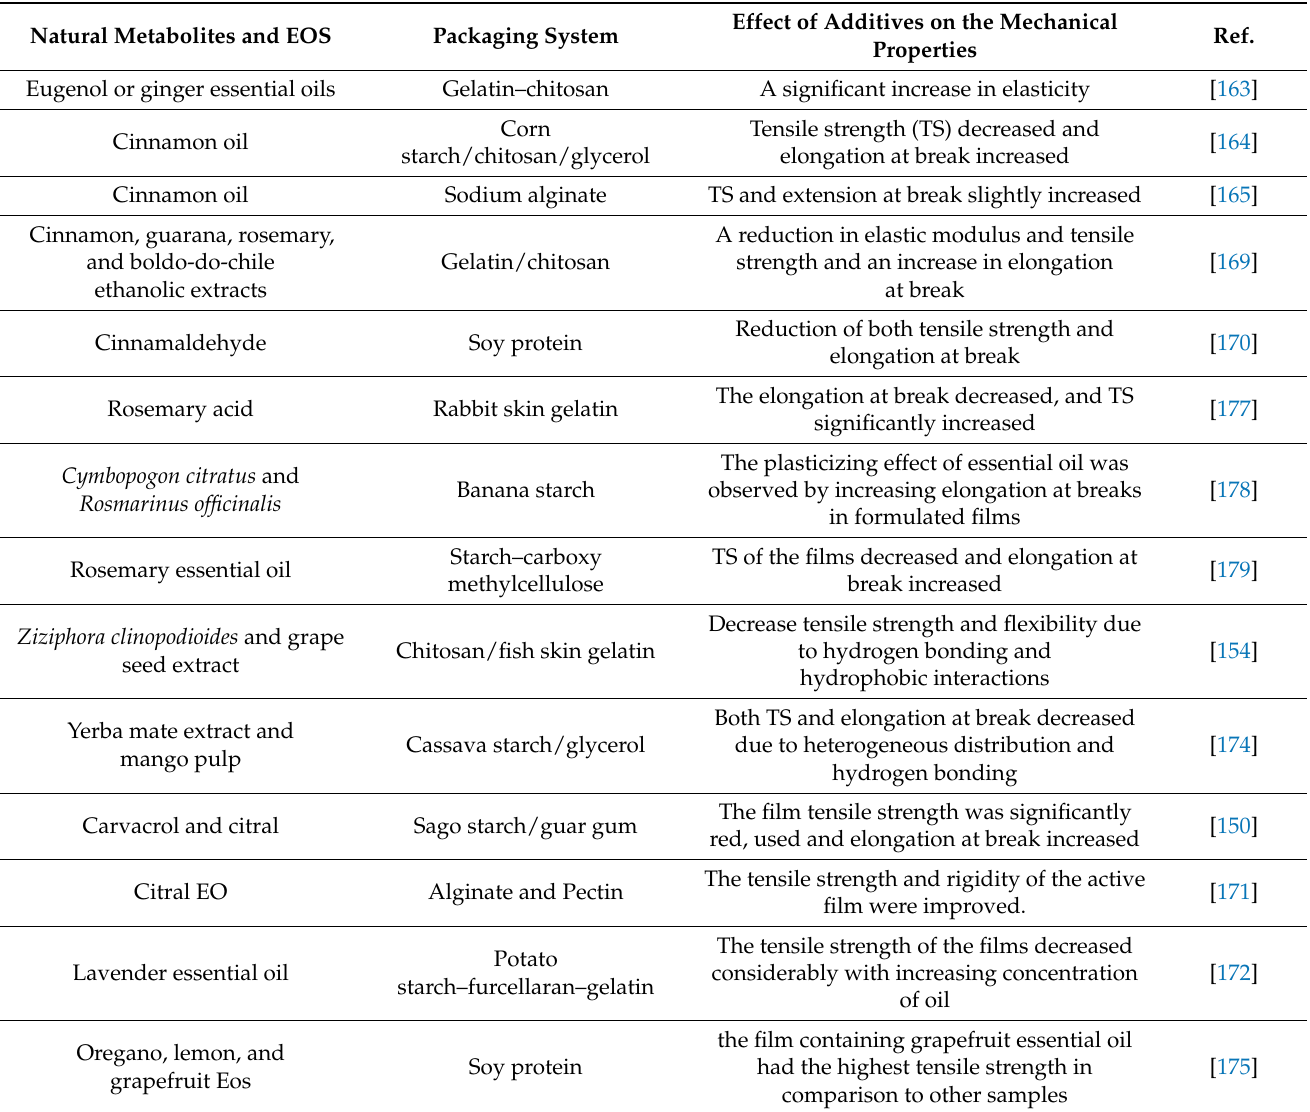
Table 2. The plasticizing effect of secondary compounds in the active biopolymer-based coating by solution